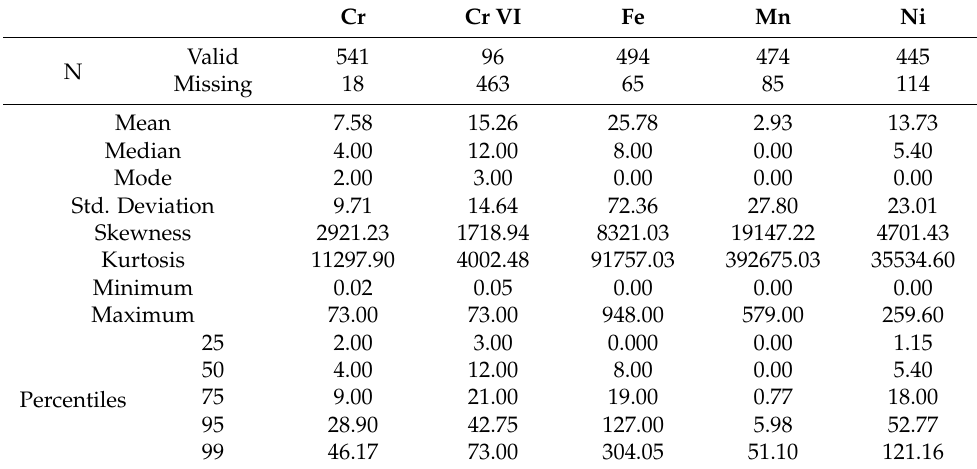
Table 8. Descriptive statistics of the PTE concentrations in Italian groundwater (in µ g/L) [50] unaffected by anthropogenic contamination (i.e., with nitrate concentrations < 37.5 mg/L). Cr Cr VI